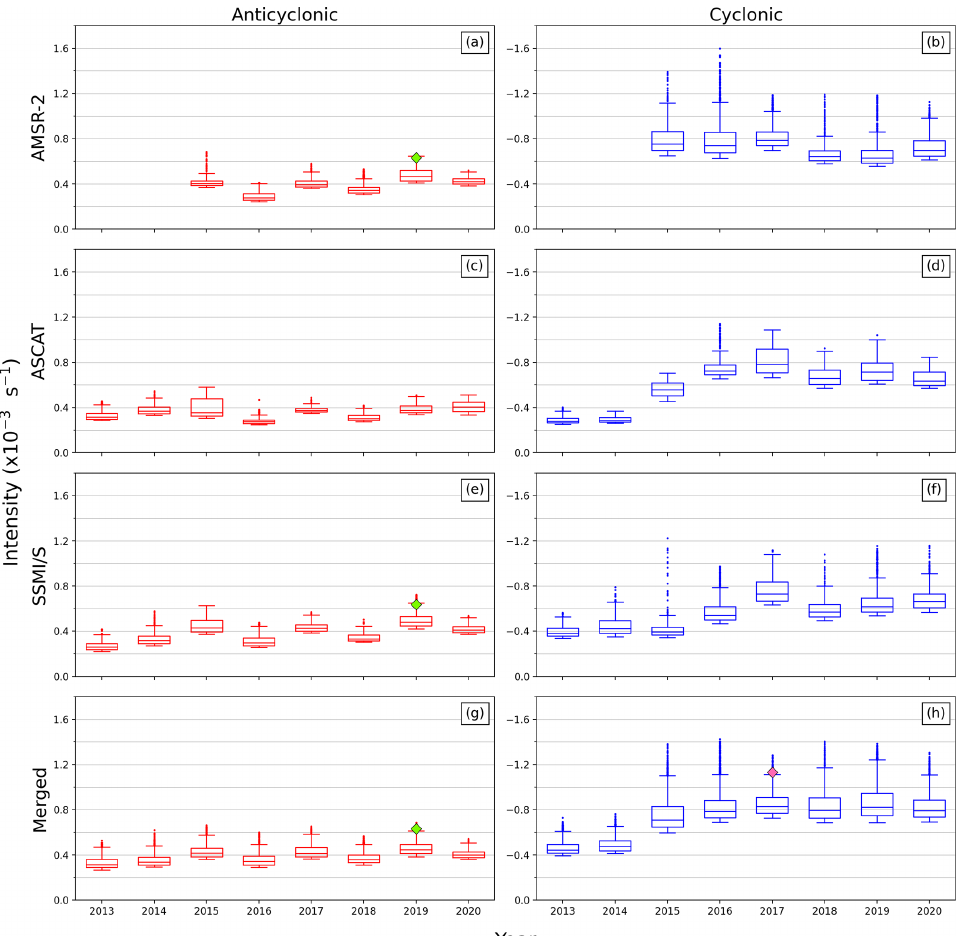
Figure 6. The interannual distribution of the 95th percentile of features detected between 2013–2020. Cyclonic and anticyclonic features are represented with blue and red box-and-whisker plots respectively. Panels (a) and (b) show features detected using the AMSR-2 product, panels (c) and (d) using the ASCAT product, panels (e) and (f) using the SSMI/S product family, and panels (g) and (h) using the merged product. The box-and-whisker rectangles indicate the interquartile range (IQR), with the median line separating the upper (Q3) and lower (Q1) quartiles. Outlier features are shown as dots and represent features of which their intensity exceeds the upper bound ( > | Q3 + 1 . 5 × | IQR | ) or lower bound ( < | Q1 |− 1 . 5 × | IQR | ). The anticyclonic feature described in Case study 2 (Sect. 4.1.2) is shown with a green diamond marker, and the cyclonic feature described in Case study 1 (Sect. 4.1.1) is shown with a magenta diamond